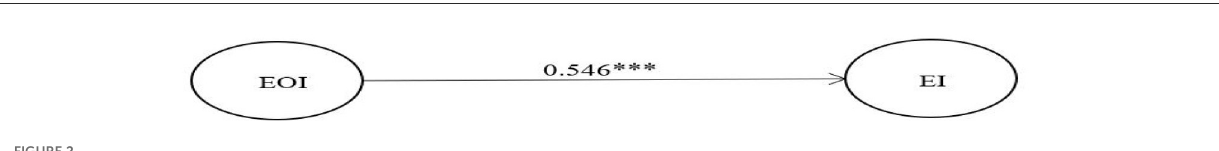
FIGURE2 The effects of EOI on EI. *** p < 0.001; EOI, entrepreneurial opportunity identification; EI, entrepreneurial intention.